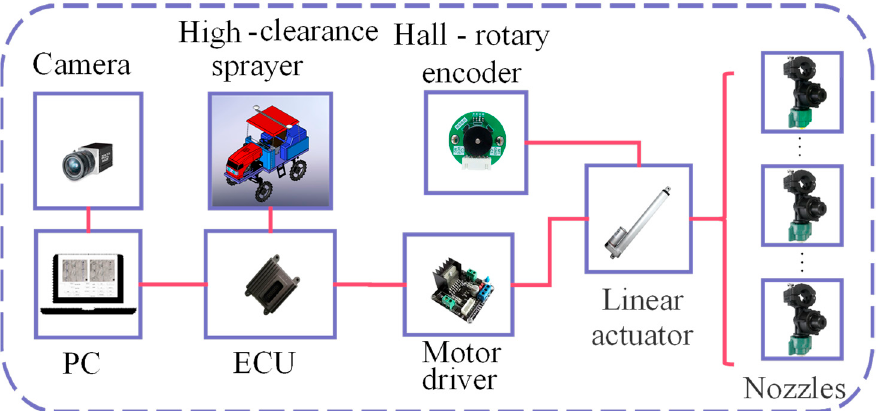
Figure 2. Composition of the visual row-oriented spraying system.